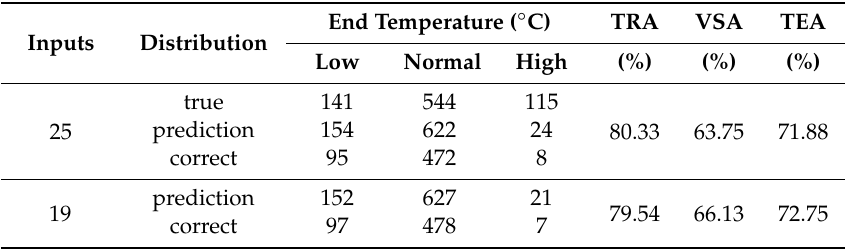
Table 2. Evaluation of the predictive performance of the proposed model.